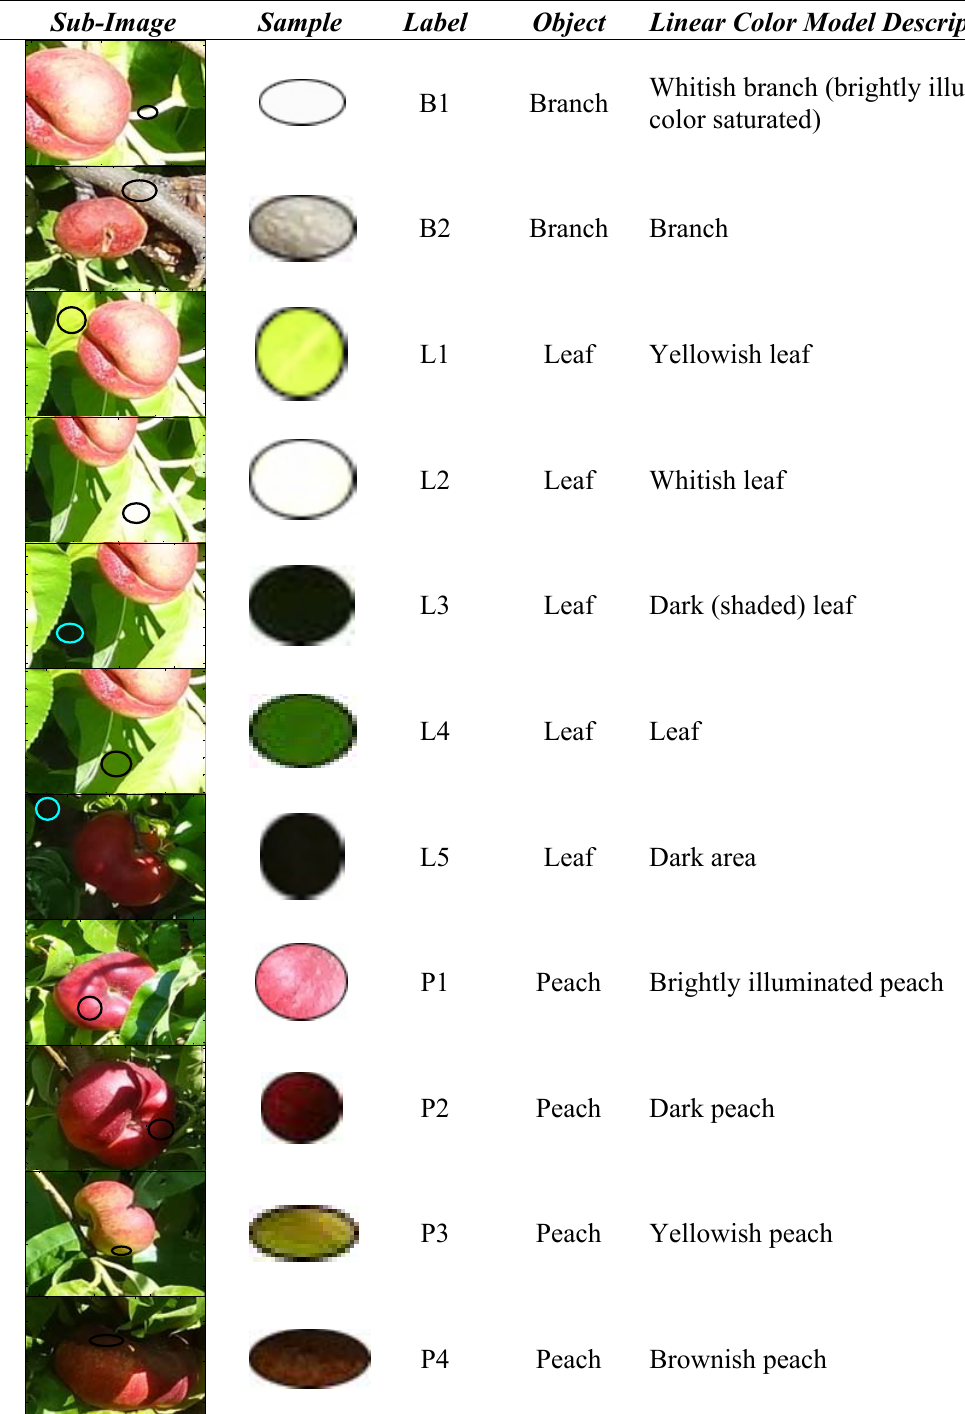
Table 1. Description of the linear color models used (plotted also in Figure